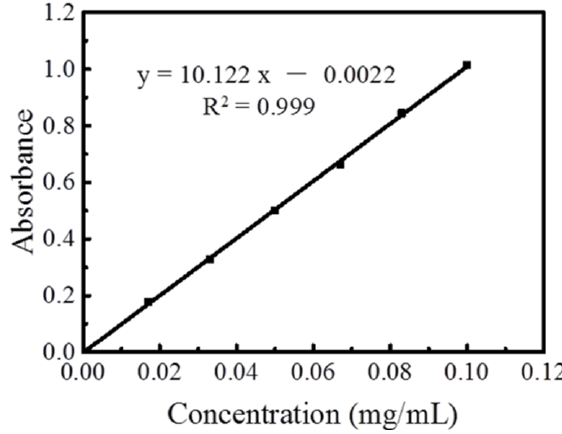
Figure 6. Rutin standard curve.